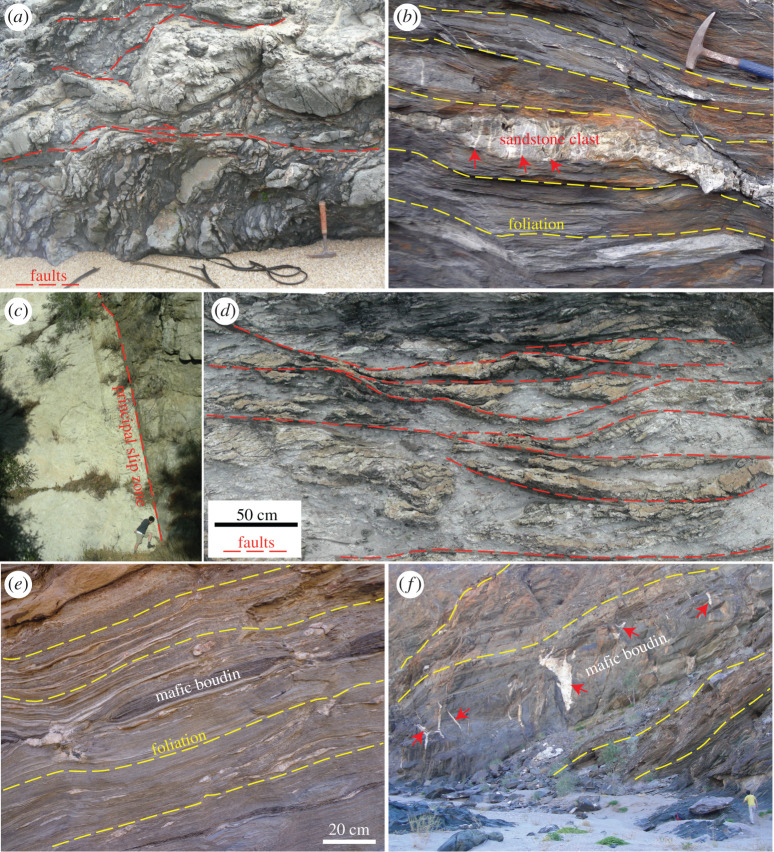
Photographs illustrating examples of lithological heterogeneity linked to deformation style, at a range of depths. In (a) dismembered bedding, developed by distributed independent particle flow in poorly to un-consolidated sediments, is crosscut by a subhorizontal through-going fault (Chrystalls Beach Complex, New Zealand [50]); (b) shows an example of a sandstone layer welded by quartz-filled fractures (red arrows at examples) that do not continue into the surrounding foliated mudstone matrix (Makimine Mélange, Kyushu, Japan [51]). An example of a cm-thick, principal slip zone in crystalline rock is found in the San Gabriel fault, California (c), and contrasts with an anastomosing fault system in the Chrystalls Beach Complex (d). In shear zones exhumed from depths below the seismogenic zone, here the Kuiseb schist that deformed at temperatures in excess of 500°C [52,53], competent mafic layers are boudinaged (e) and locally fractured and faulted (red arrows in f ). (Online version in colour.)